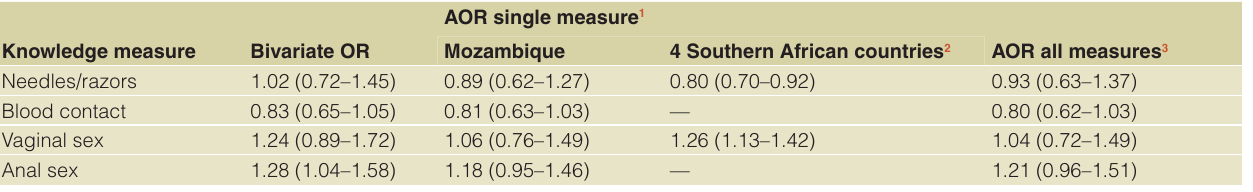
Table 2. Associations between measures of knowledge of HIV transmission modes and prevalent HIV infection, Mozambican women,